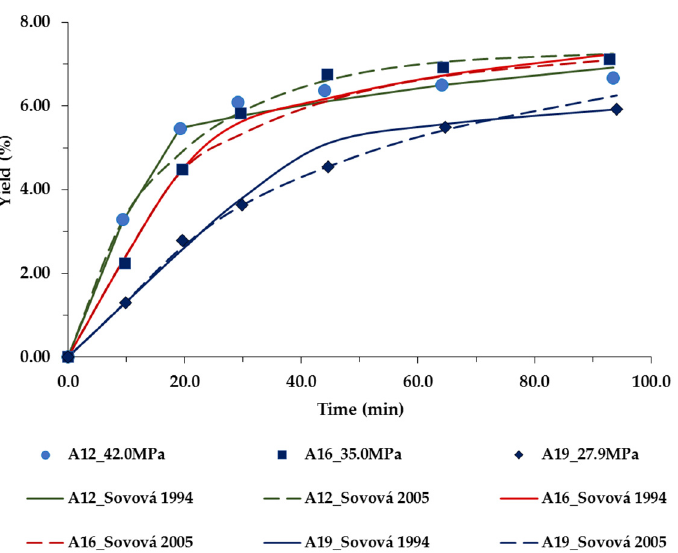
Figure 5. Extraction yield curves representing the influence of pressure (MPa) at temperature (338.15 (338.15 K) and CO 2 flow rates (1.8 × 10 − 3 kg/min), on bran rice oil yield, as a function of time. The K) and CO 2 flow rates (1.8×10 − 3 kg/min), on bran rice oil yield, as a function of time. The symbols are the experimental data, and line-model predictions. symbols are the experimental data, and line-model